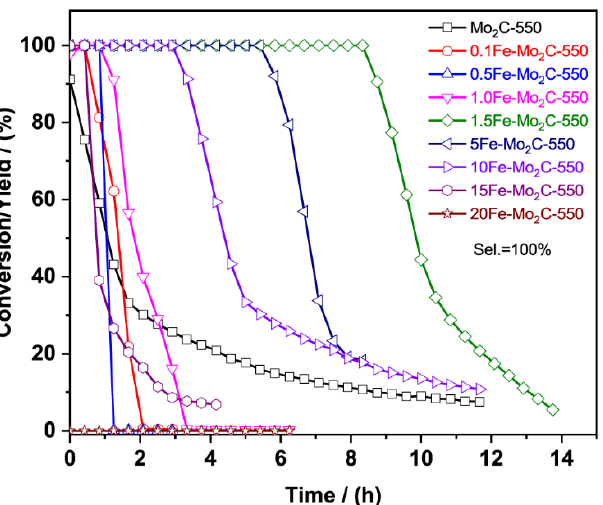
Figure 5. Effect of Fe doping amounts (xFe-Mo 2 C-550, x = 0.1, 0.5, 1.0, 1.5, 5, 10, 15, 20) on toluene hydrogenation. (3.0 MPa of total pressure, 100 ° C as reaction temperature, 0.15 h − 1 as WHSV, employing newly synthesized Fe-doped molybdenum carbide catalysts).